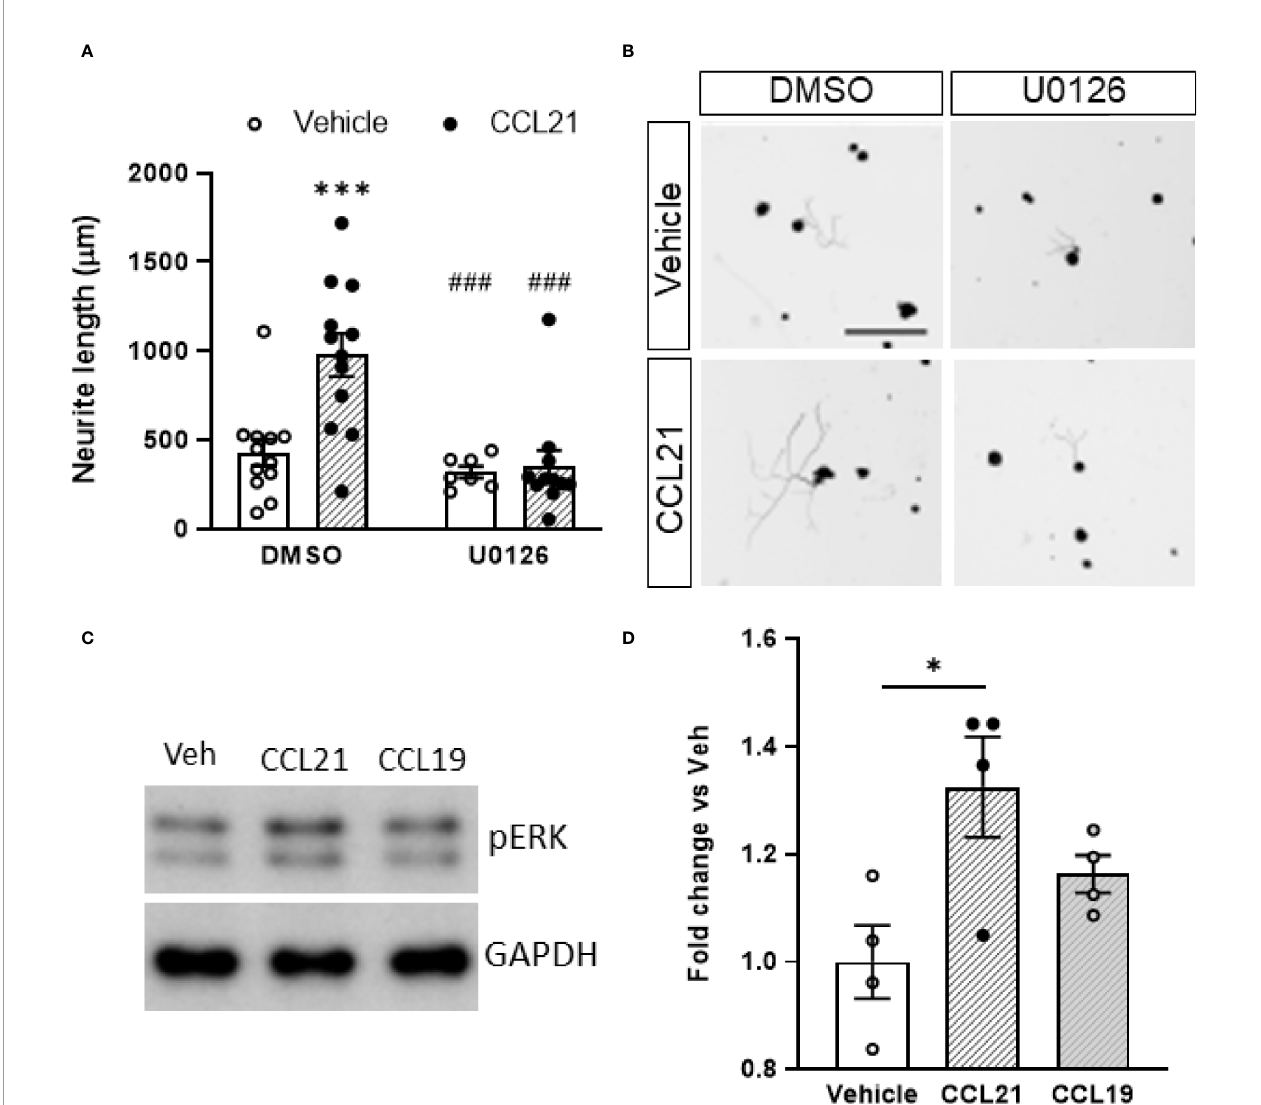
FIGURE 4 | CCL21 induced outgrowth through biased activation of the MEK/ERK pathway. (A) CCL21 and U0126, a MEK inhibitor, co-administration resulted in reduced neurite outgrowth compared to CCL21 administration alone. Data are expressed as average neurite length per neuron ± s.e.m; Two-way ANOVA, Bonferroni ’ s post-hoc ; *** p < 0.001 (vs veh-DMSO), ###p < 0.001 (vs CCL21-DMSO). n=7-12 images. (B) Tuj-1 representative immunostainings after 24h in culture. Scale bar: 250 m m. (C) Representative Western Blot images showing pERK expression in CCL21 and CCL19-treated DRG cultures. (D) pERK expression is increased 50 minutes after the administration of CCL21, while the administration of CCL19 shows a reduced pERK induction. Data are expressed as mean ± s.e.m; One-way ANOVA, Bonferroni ’ s post-hoc ; *p < 0.05;